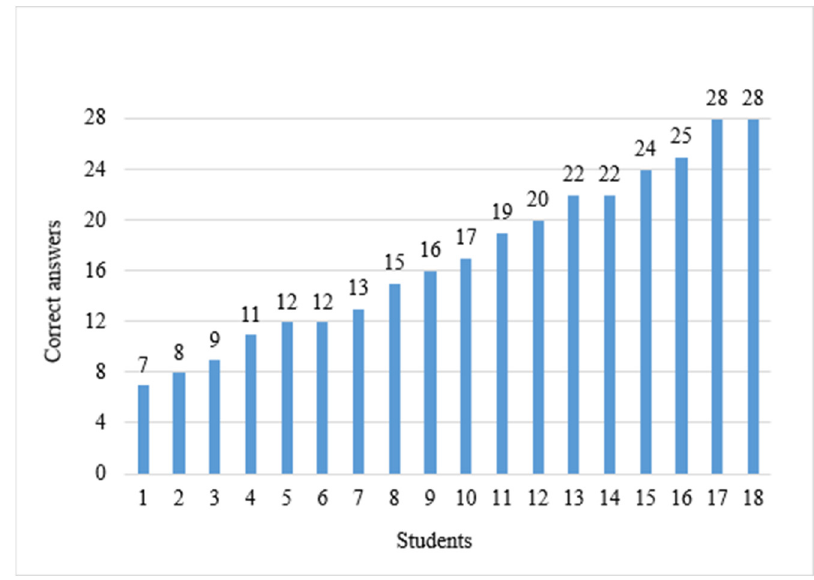
Figure 13. Fourth grade students’ performance (correct answers) in the pre-test.